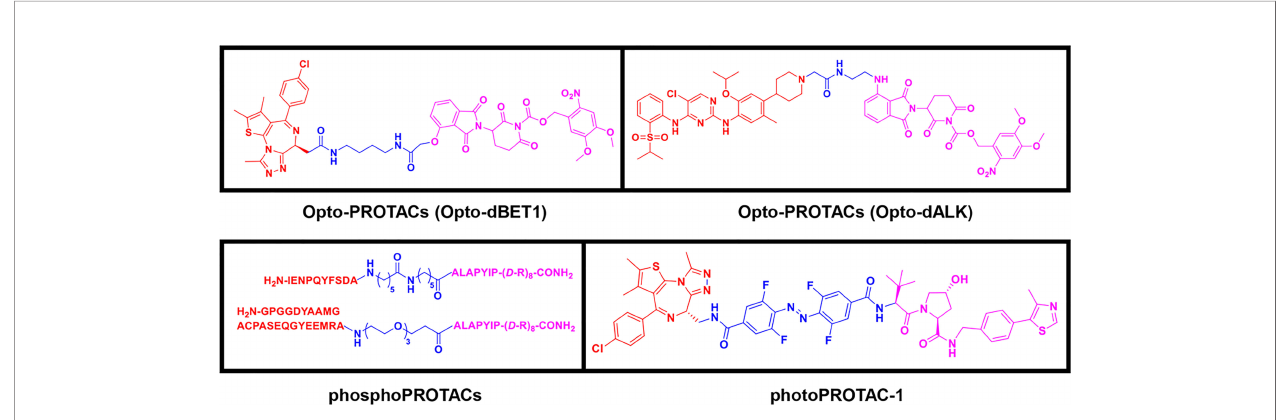
FIGURE 4 | Third-generation PROTACs, Controllable PROTACs. Chemical structures of representative opto-PROTACs (opto-dBET1 and opto-dALK), representative phosphoPROTACs, representative photoPROTACs.